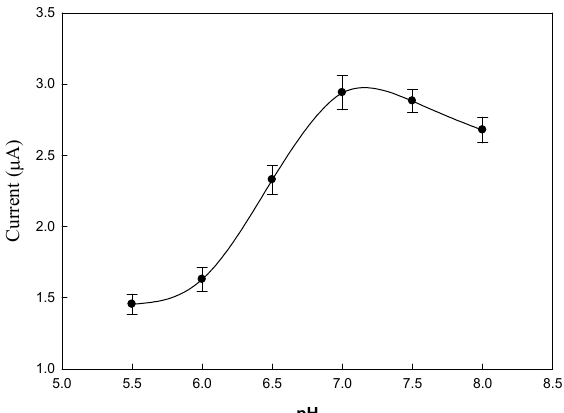
Figure 7. The pH influence of the solution on the detection of 50 μ M tryptophan. Applied potential: 0.65 V.